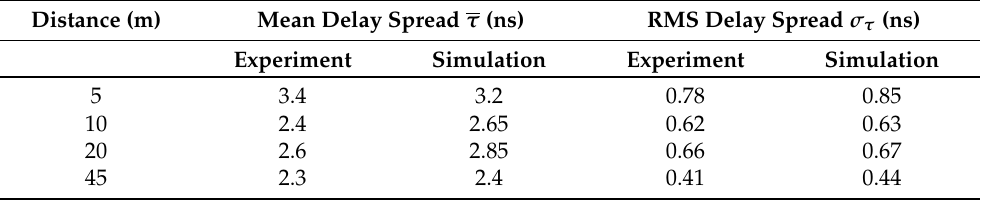
Table 7. Average and RMS delay spread for various